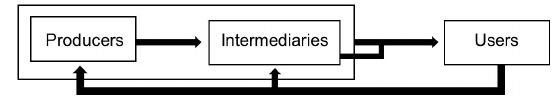
Figure 1. Diagram indicating common relationship patterns be- tween the roles of producers, intermediaries, and users in bulletin development and production. Arrows indicate typical flows of in-